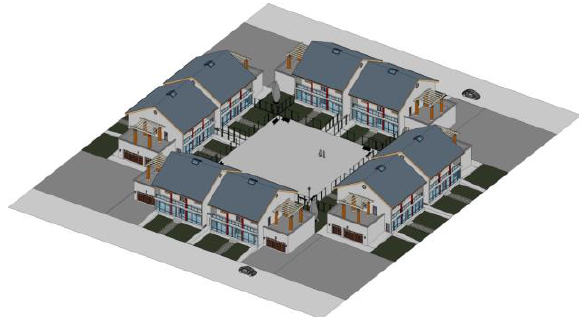
Figure 25 . Beijing new courtyard garden house compound based on a system of 60 m × 60 m standard block size, a communal courtyard of 26 m × 26 m shared by eight nuclear families, with each household enjoying a private garden at the back. Each housing unit measures 6 m × 10 m (total 180 sqm) with a semi-basement and 2 ½ storeys. Design and computer model by Donia Zhang 2016b.